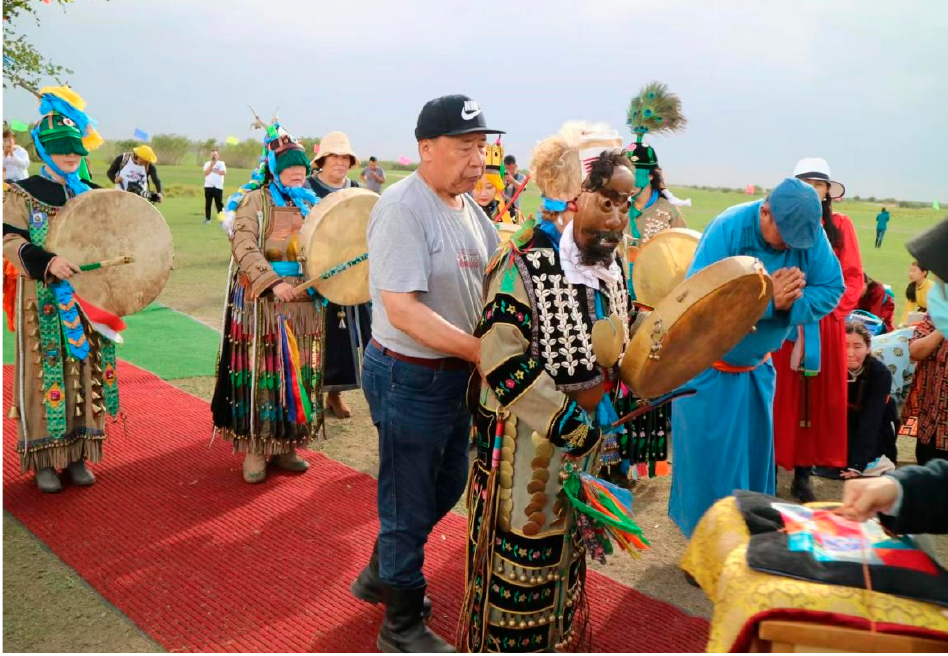
Figure 1. Shaman Siqinggua in the state of connecting earth and heaven in the Ominan ritual. Pho- tograph by Liu Xiaoshuang, 30 September 2020.